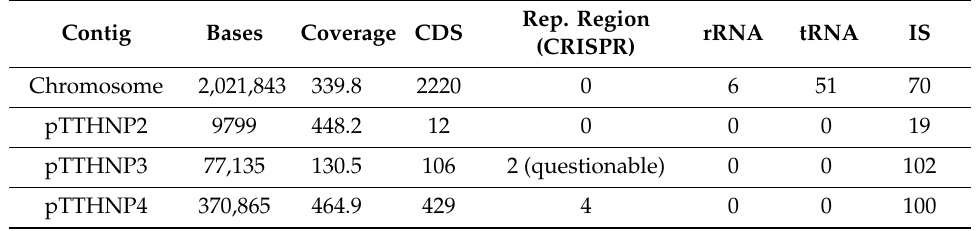
Table 1. Summary of features of the consensus TthNAR1 replicons. CDS, RNA and tRNA were identified with PROKKA, and IS using the ISFinder